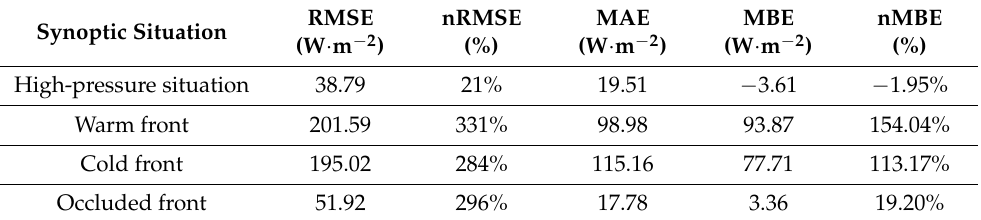
Table 10. Error values: RMSE, nRMSE, MAE, MBE, nMBE for individual synoptic situations (Dudhia).